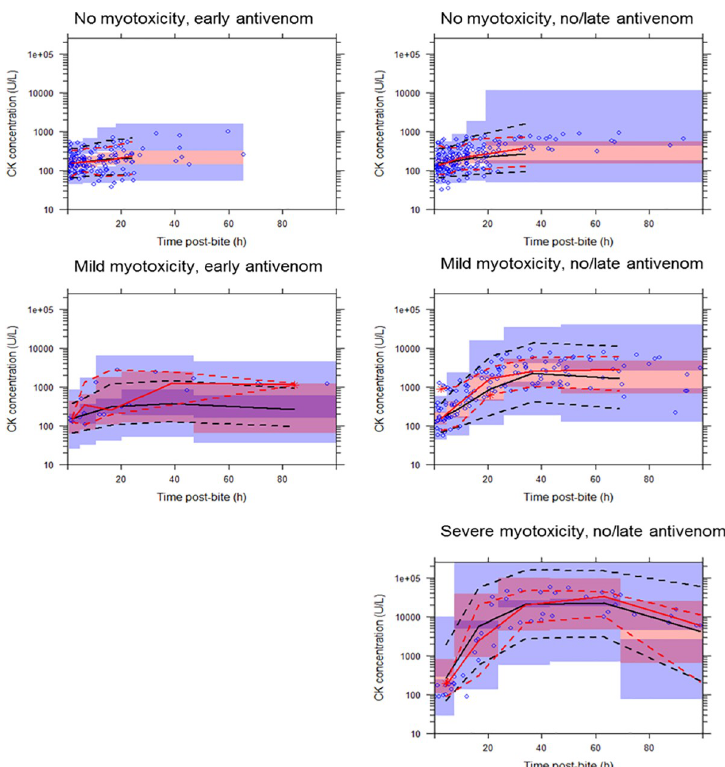
Fig 5. Visual predictive checks showing the observed timed creatine kinase (CK) concentration (U/L) versus time post-bite (h) described by a population kinetic-pharmacodynamic model with linear linker function (model parameters were separated for each CK group level) to describe venom-effect relationship. The solid red line represents the median observed CK concentration, and the dashed lines represent the observed 10th and 90th percentiles. The solid black line represents the median simulated CK concentration, and the dashed lines represent the simulated 10th and 90th percentiles. Shaded areas are the corresponding 95% confidence intervals of the observed percentiles based on the simulated data. Patients data were categorised into three groups based on measured peak CK concentration: (a) no myotoxicity (CK < 1000 U/L); (b) mild myotoxicity (1000 U/L < CK < 10,000 U/L); and (c) severe myotoxicity (CK > 10,000 U/L). Plots on the left panel are for patients that received early antivenom (within 6 hours), and on the right are those that received no or late antivenom.